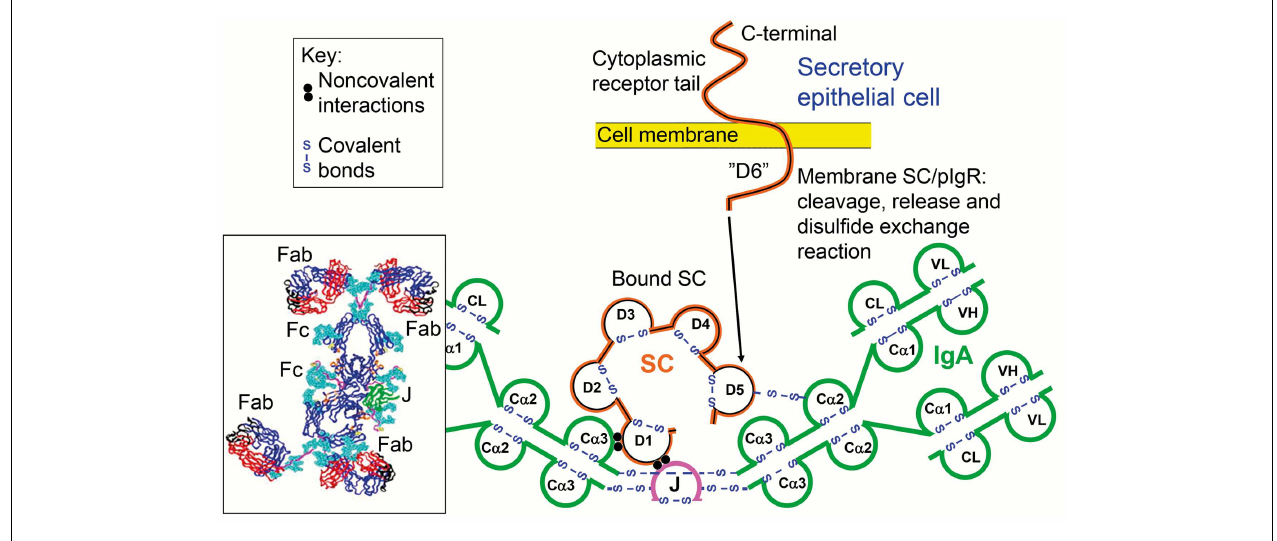
domain of one of the two IgA subunits. Some studies have indicated that there may be two J chains in dimeric IgA (30). Insert to the lower left is from modeling data for dimeric IgA1 based on X-ray and neutron scattering in solutions published in Bonner et al. (63). Note theT-shape of the Fab fragments, allowing for antibody binding to large particles like bacteria.V, variable region; C, constant region; L, light chain; H, heavy chain; Fab, fragment antigen binding; Fc, fragment crystallizable.